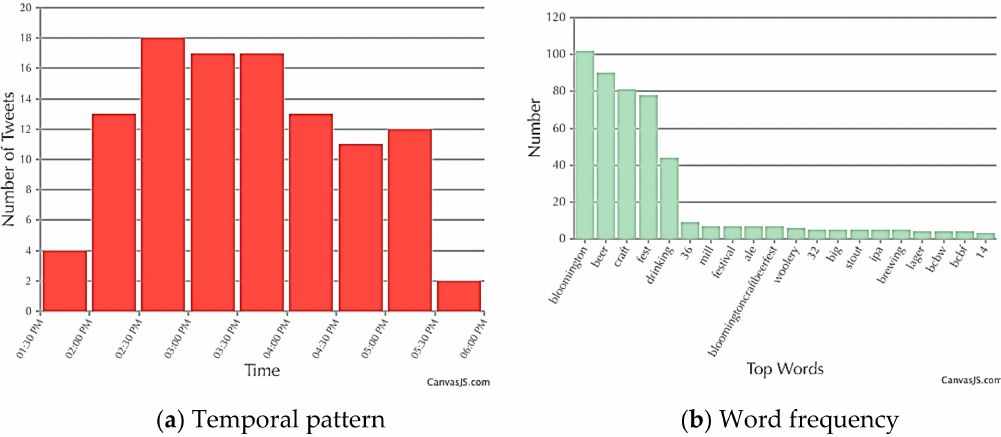
Figure 9. Temporal pattern and word frequency of the Craft Beer Festival in Bloomington: ( a ) Temporal pattern; and ( b ) Word frequency.